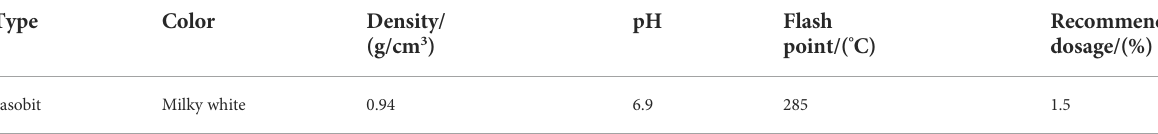
TABLE 2 Main characteristics of Sasobit warm mix.